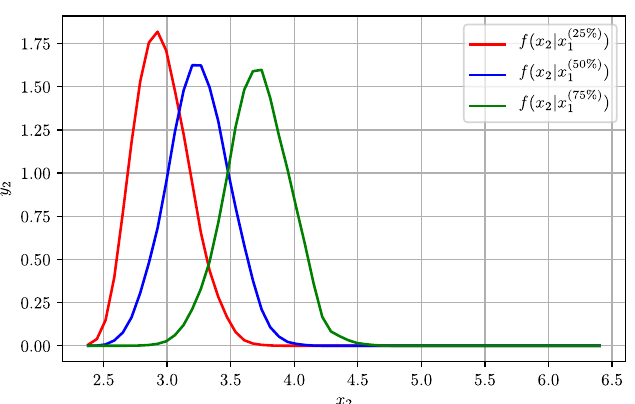
Fig. 7. Visualization of the Rosenblatt conditional density f ( x 2 | x 1 ) .